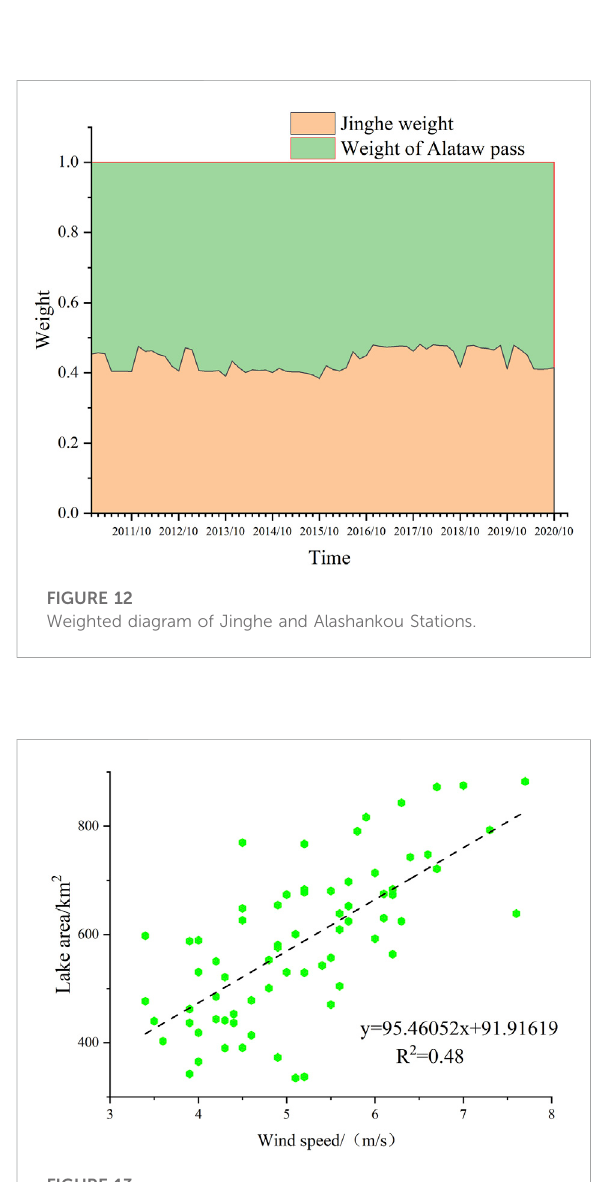
FIGURE 13 Linear fi tting between wind speed and lake surface